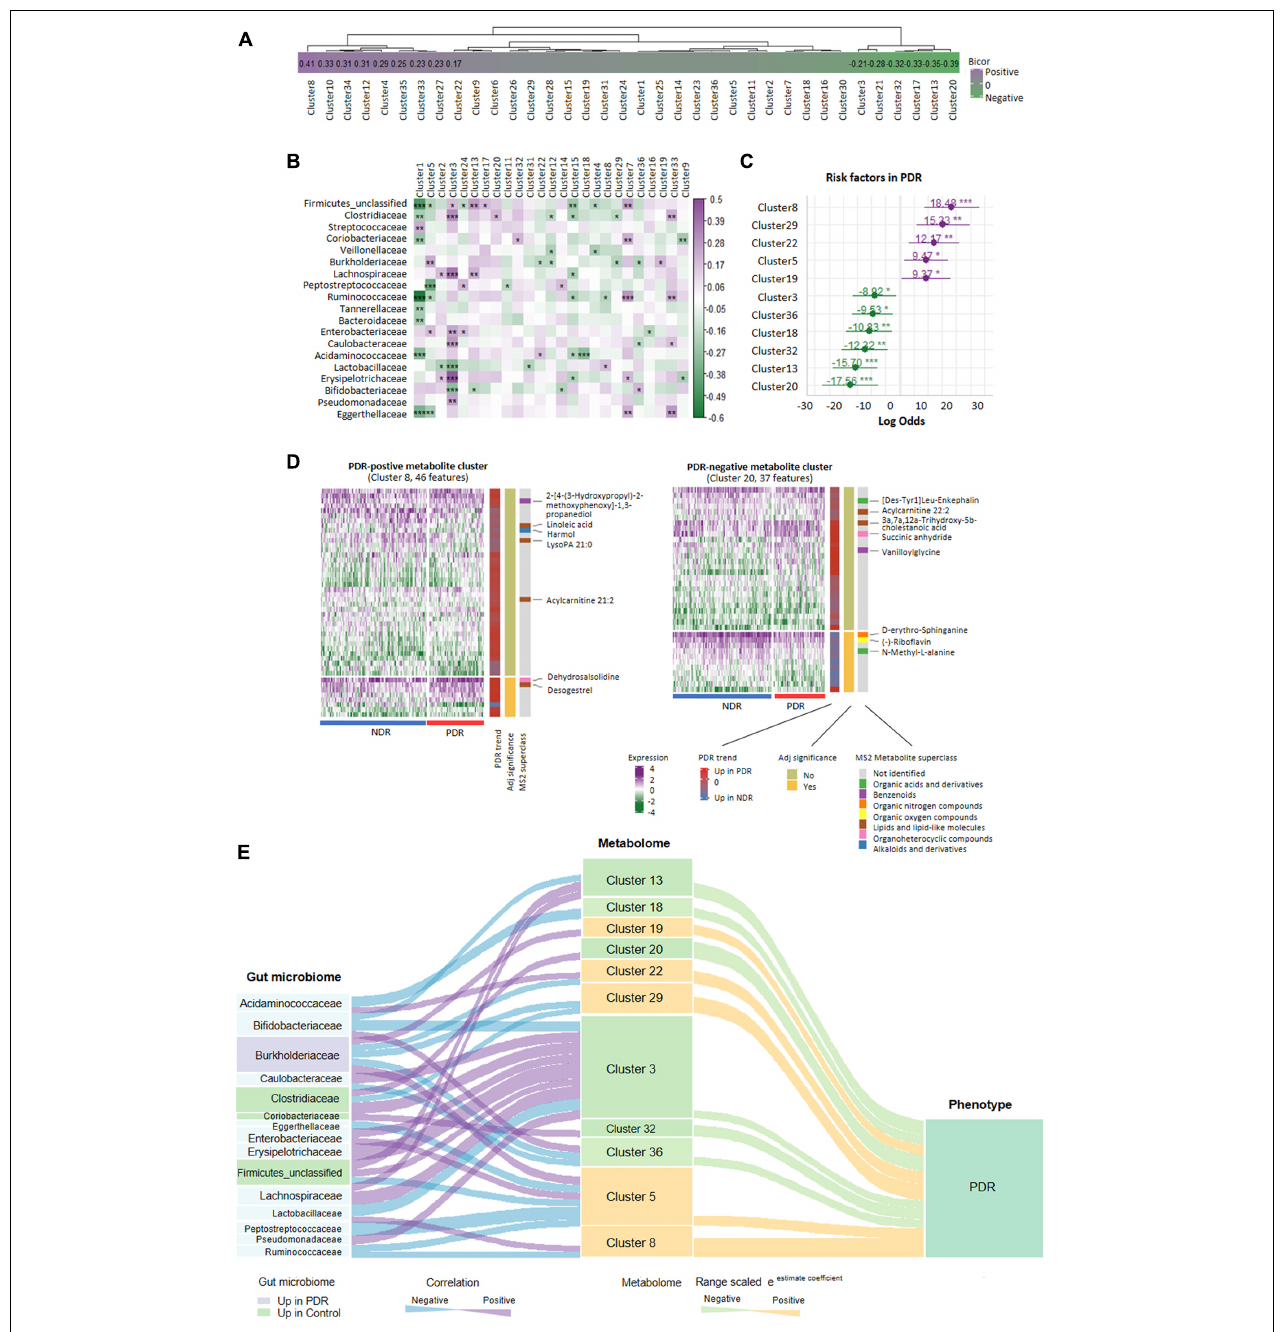
FIGURE 4 | Relationship network between proliferative diabetic retinopathy-linked microbes and metabolites. (A) PDR-associated coabundance clusters as revealed by biweight midcorrelation analysis. (B) Significantly correlated gut microbiota families with coabundance clusters as shown by Spearman correlation analysis (*** p < 0.001; ** p < 0.01; * p < 0.05). (C) The positive/negative metabotypes of PDR as identified by logistic regression analysis. (D) The detailed description of representative positive/negative metabotypes of PDR as analyzed by coabundance correlation network. (E) Visualization of the gut microbiota-metabolites network according to Spearman correlation analysis (curve on the left) and logistic regression (curve on the right). PDR, proliferative diabetic retinopathy; NDR, diabetic patients without retinopathy.